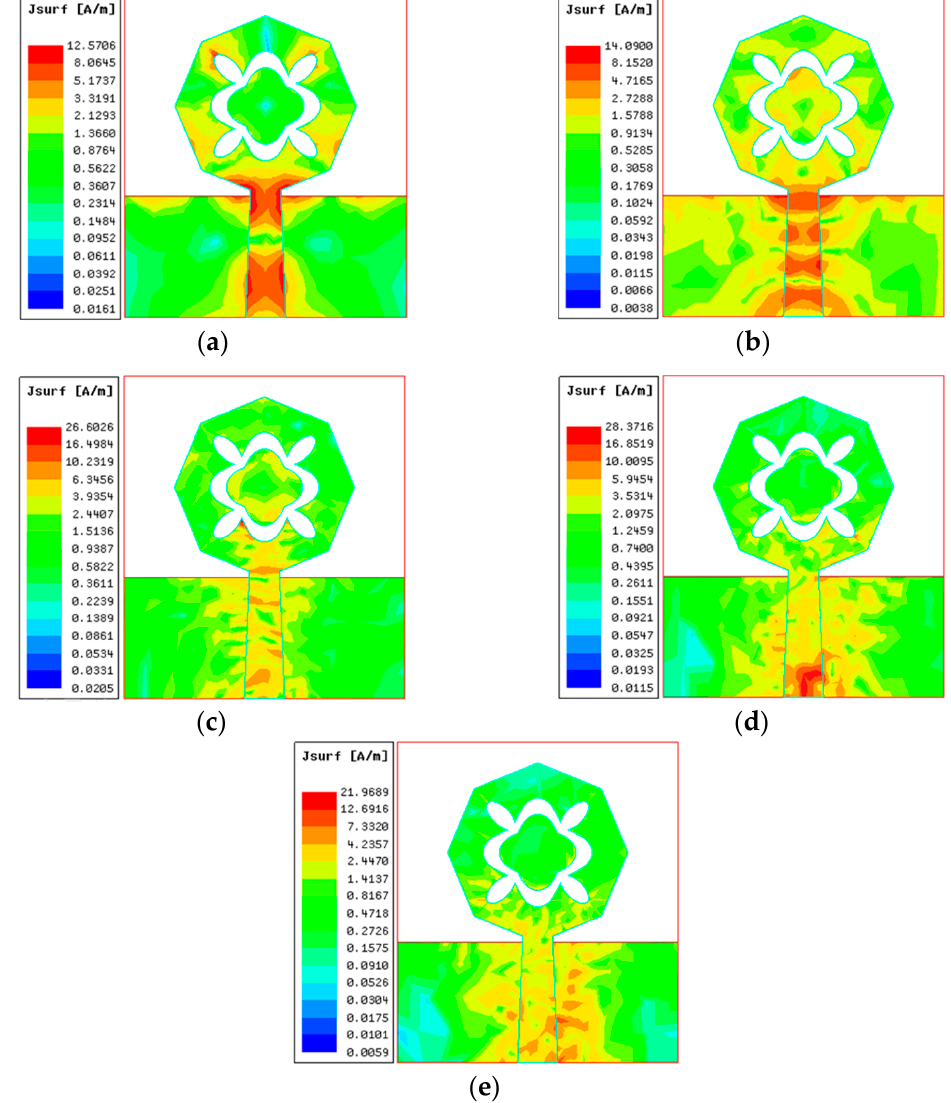
Figure 8. The surface current distribution of the designed antenna for ( a ) 24.1 GHz, ( b ) 67.1 GHz, ( c ) 129.1 GHz, ( d ) 249.1 GHz, ( e ) 287.1 GHz.